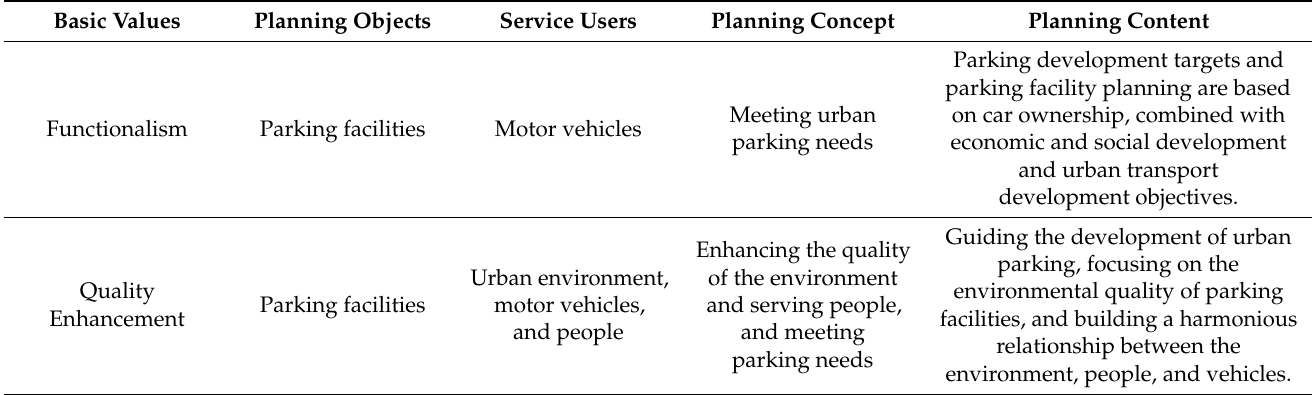
Table 1. Planning values for urban parking facilities.